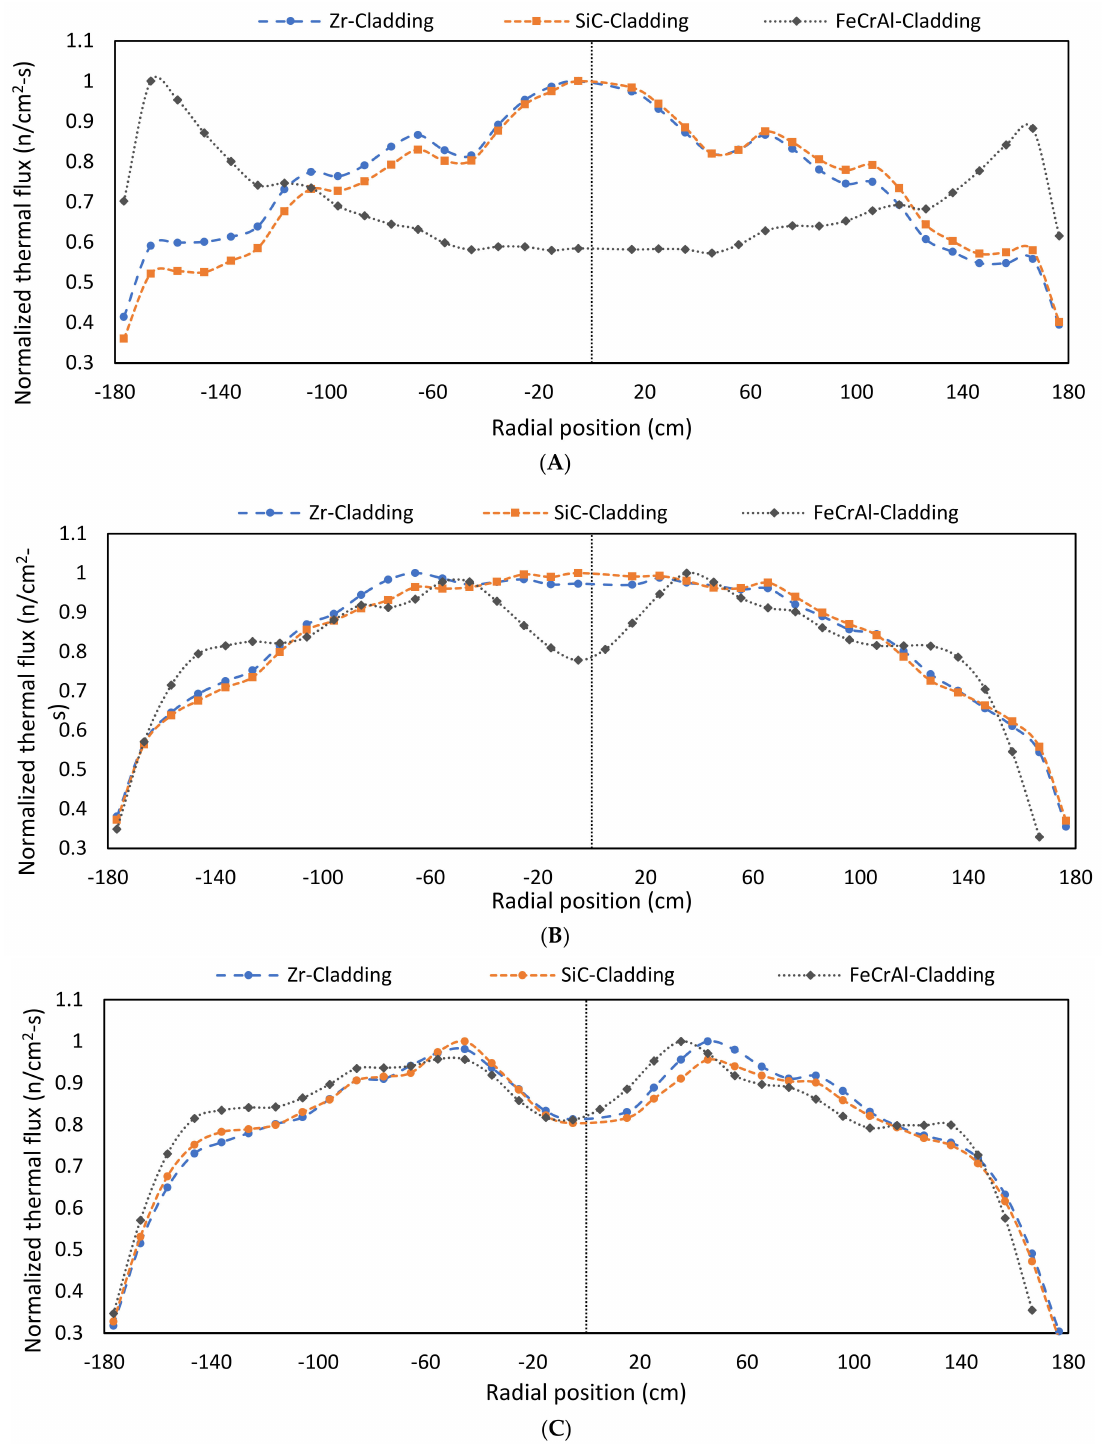
Figure 14. Radial power profile for three types of cladding materials at ( A ) BOC, ( B ) MOC, and ( C ) EOC,